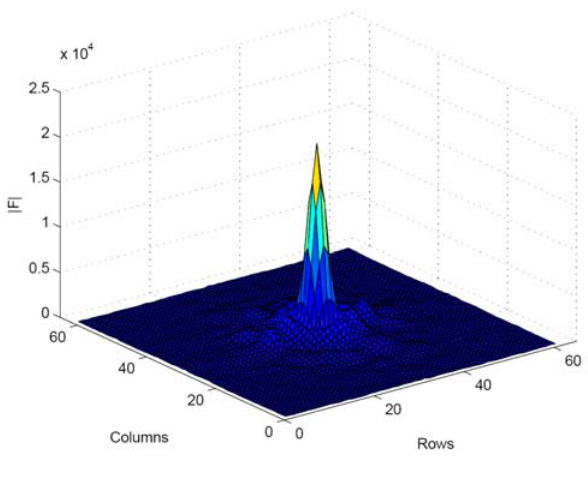
Figure 2. Amplitude spectrum of a representative image of the